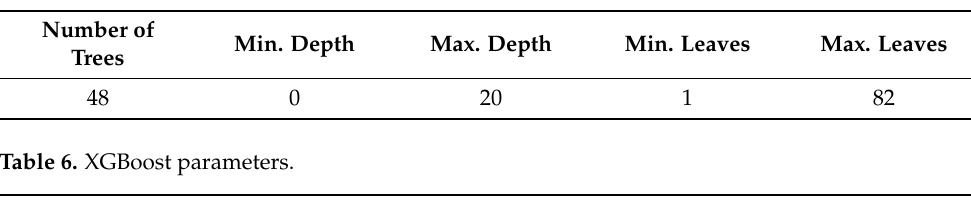
Table 5. DRF parameters.